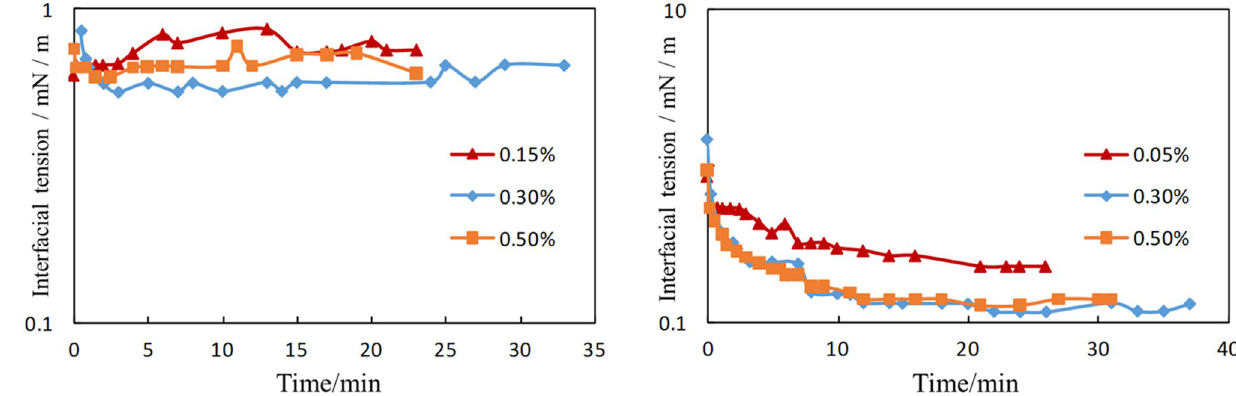
Fig. 1 Interfacial Tension (IFT) variation between surfactant LAO (left) and AEO (right) with crude oil